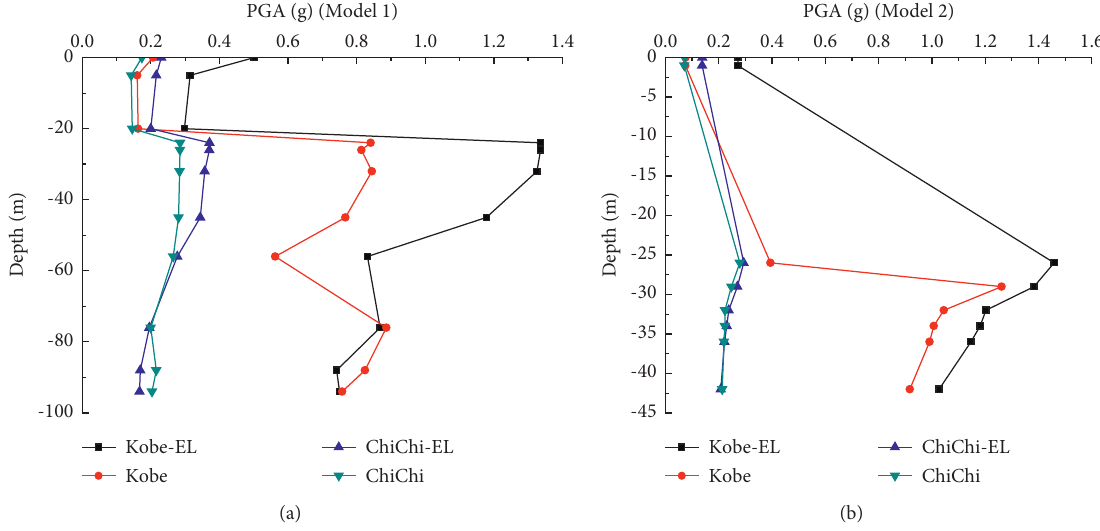
Figure 10: Maximum acceleration of soil in model 1 and model 2.